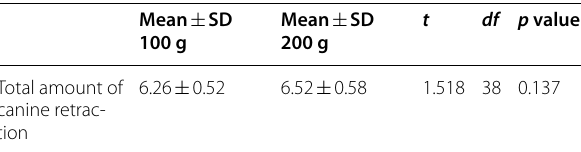
Table 5 Means, standard deviations and the p value of the independent sample t test of the total amount of canine retraction by 100 and 200 g of